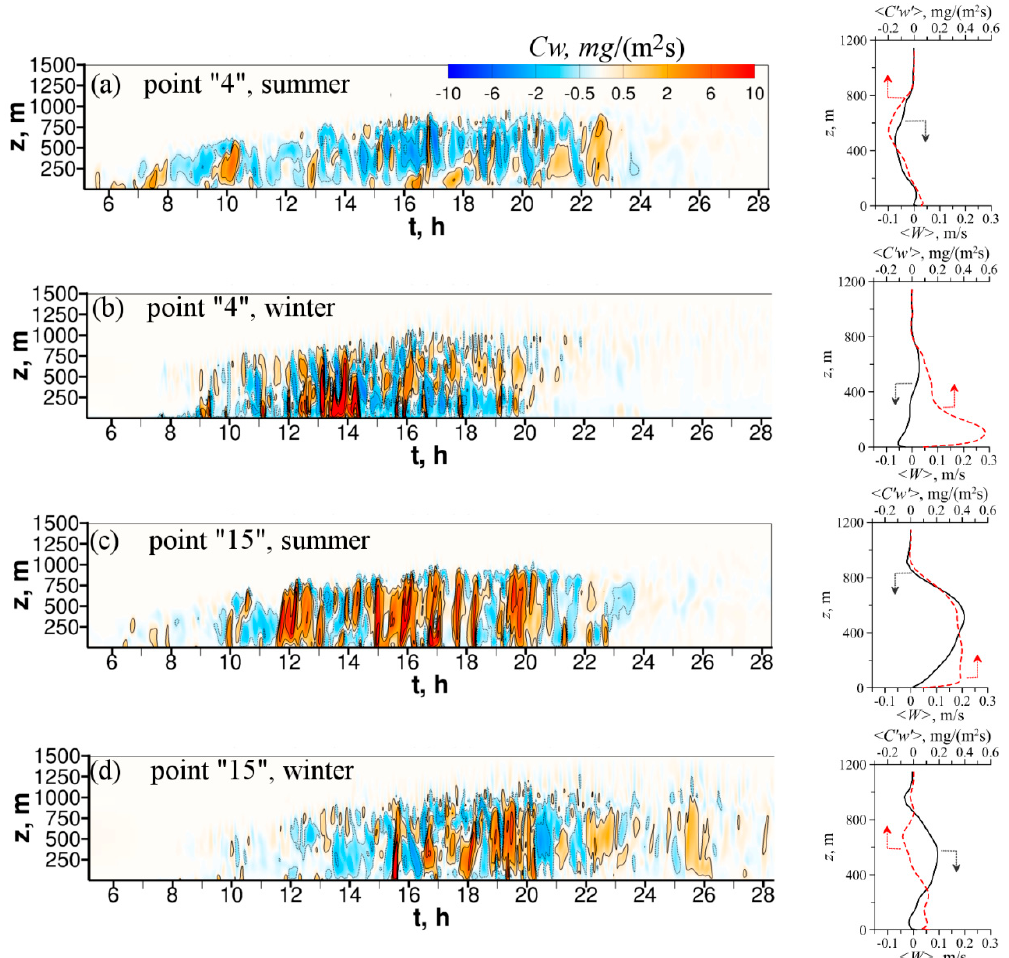
Figure 14. Temporal evolution of vertical advection intensity ( Cw ) (left) and daily-averaged profiles of vertical velocity and vertical turbulent concentration flux < c ’ w ’ > (right) for several points (shown in Figure 1). ( a , c ) Summer case; ( b,d ) Winter case.